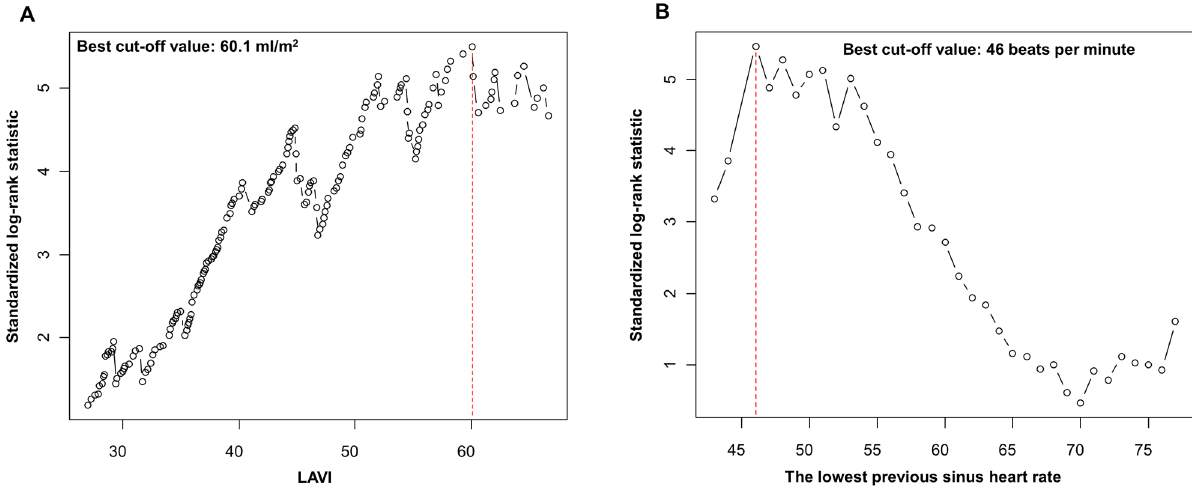
Figure 2. Best cut-off value of LAVI and the lowest previous sinus heart rate for the prediction of PPM implantation after CTI-dependent AFL ablation. Best cut-off value of LAVI and the lowest previous sinus heart rate to predict the risk of PPM implantation after CTI-dependent AFL ablation which was evaluated by the maximally selected log-rank statistics method. ( A ) The best cut-off value of LAVI was > 60.1 ml/m 2 ( B ) The best cut-off value of the lowest previous sinus heart rate was < 46 beats per minute. AFL atrial flutter, CTI cavotricuspid isthmus, LAVI left atrial volume index, PPM permanent pacemaker.